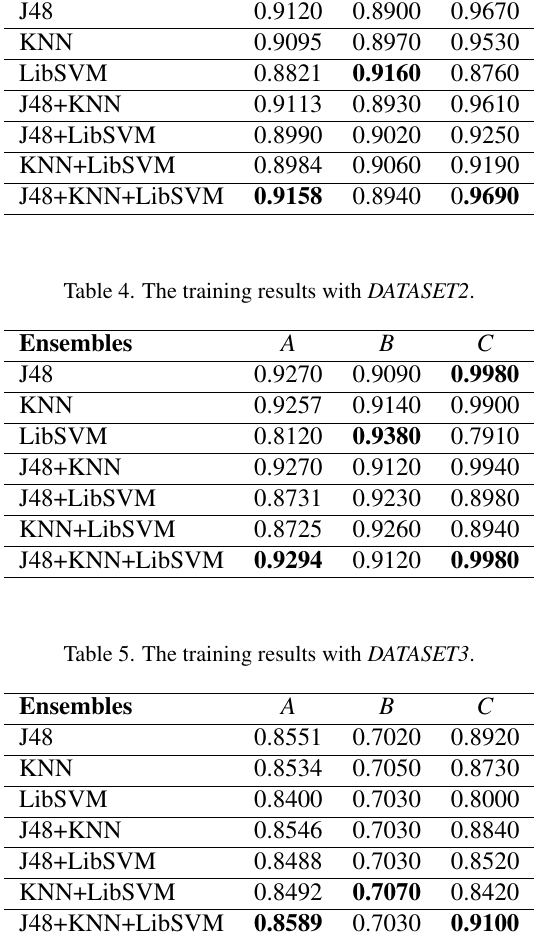
Table 3. The training results with DATASET1 .